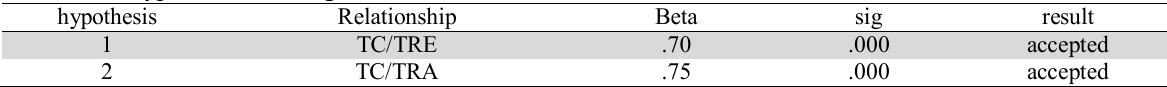
Results of hypotheses